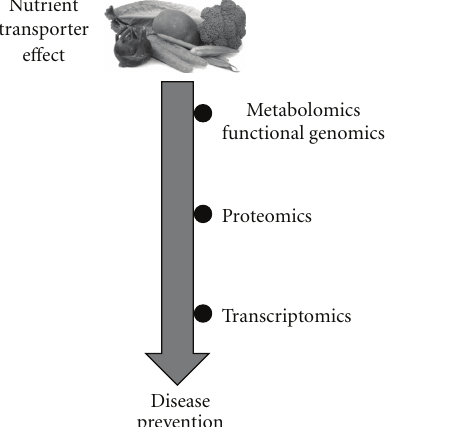
Figure 5: Nutrigenomics is a science that studies how food components exert their influence on metabolism pathways and manipulate genetic transcription, which can be used for disease prevention.